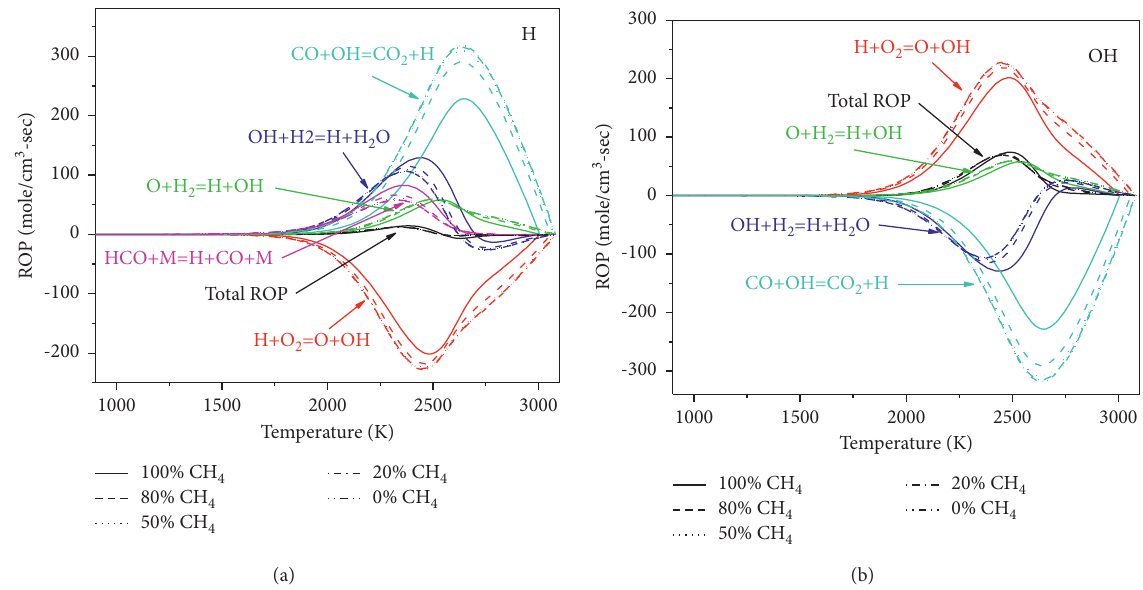
Figure 14: Rates of production and consumption for H and OH radicals under different methane-n-dodecane mixing ratios.